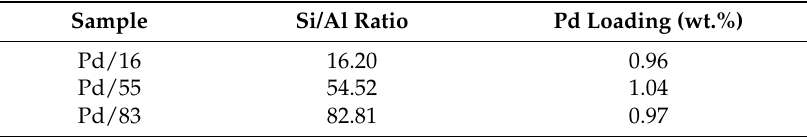
Table 1. Loading and Si/Al ratios of each